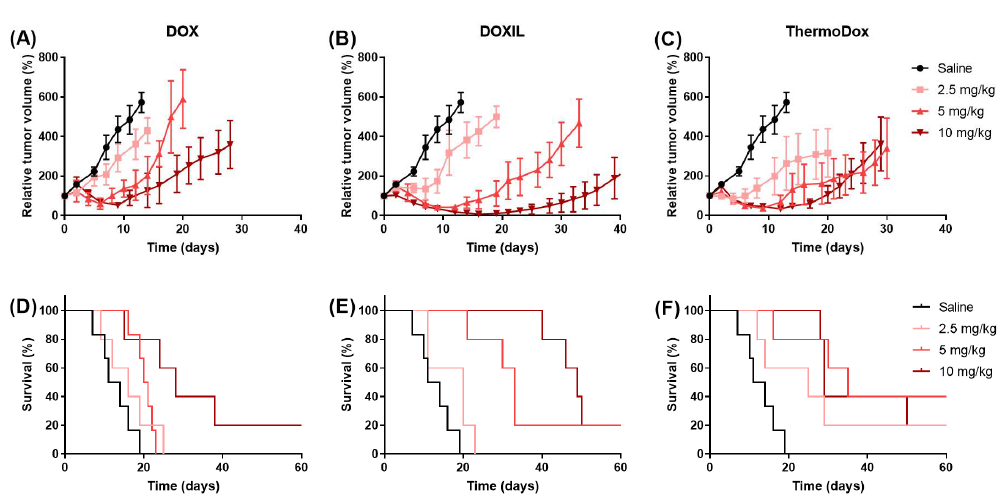
Figure 1. Tumor growth and survival (“tumor volume five times larger than the initial tumor volume”). Relative tumor volume and survival of tumors treated with saline, doxorubicin (DOX) ( A and D ), DOXIL ( B and E ), and ThermoDox ( C and F ) at a dose of 2.5, 5, and 10